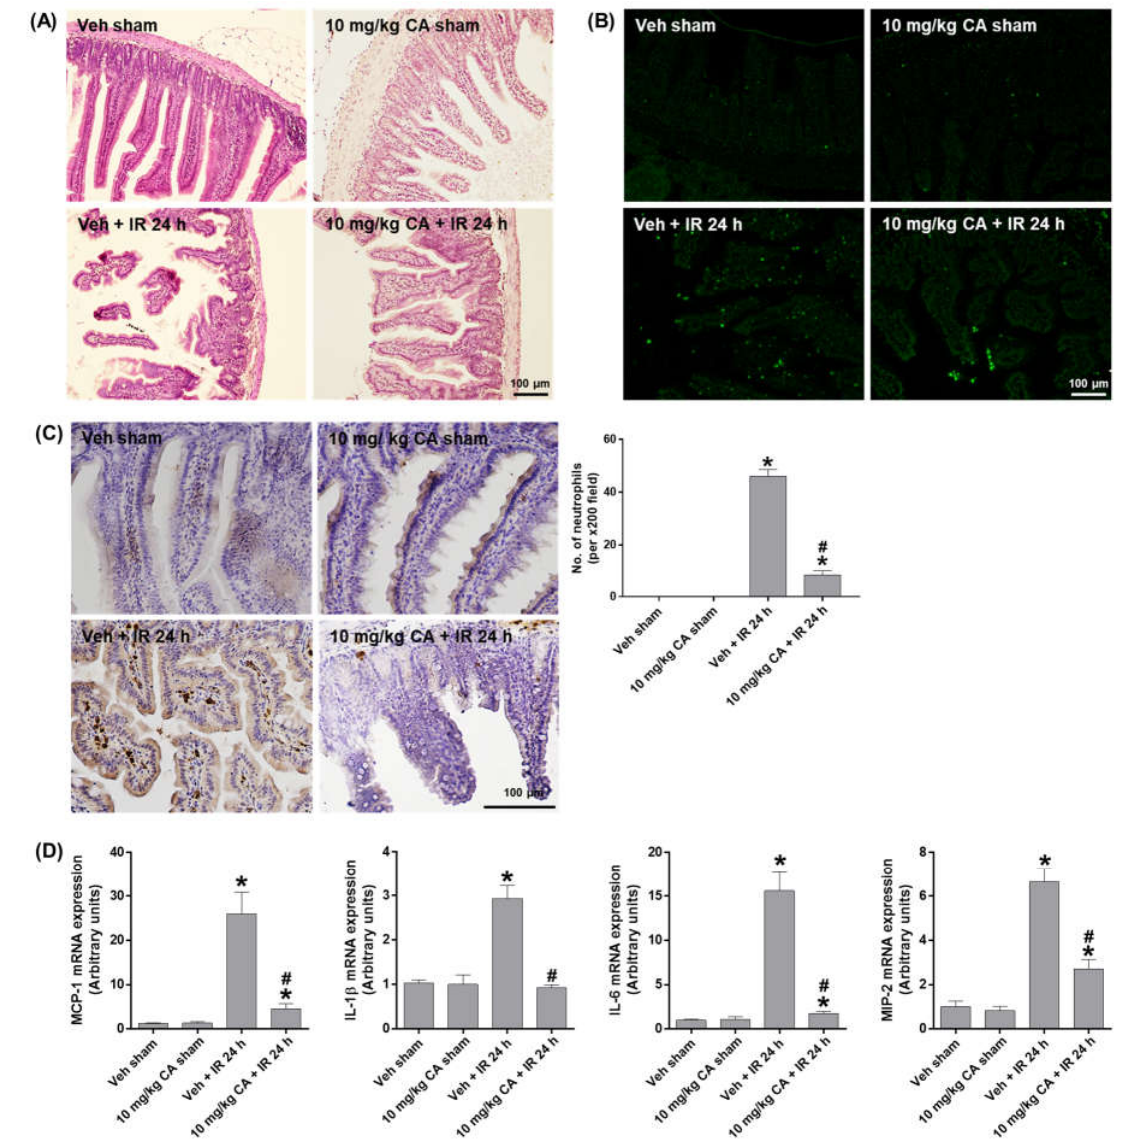
Figure 4. CA reduces small intestinal damage, apoptosis, neutrophil infiltration, and inflammatory cytokines in the small intestine of IR mice. Representative images of H&E staining ( A ), TUNEL staining ( B ), and PMN staining ( C ) of small intestine sections; the number of neutrophils was counted per ×200 field. Intestinal mRNA expression of proinflammatory cytokines, MCP-1, IL-1β, IL-6, and MIP-2; relative mRNA levels were normalized to levels of GAPDH ( D ). The values are expressed as the means ± SEM. * p < 0.05 compared to sham group. # p < 0.05 compared to IR group.